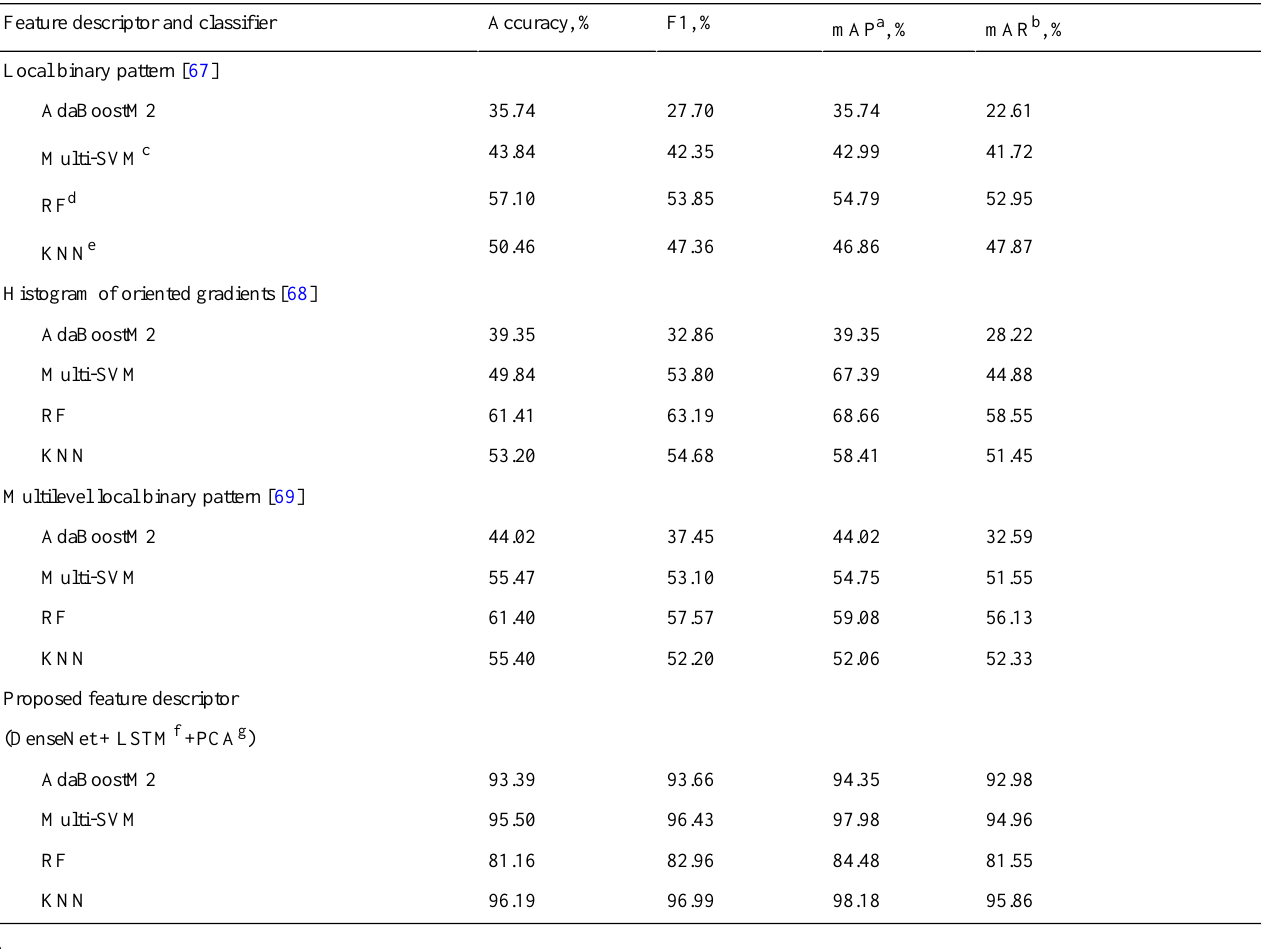
Table 4. Classification performance comparison of our proposed method with the other handcrafted feature–based